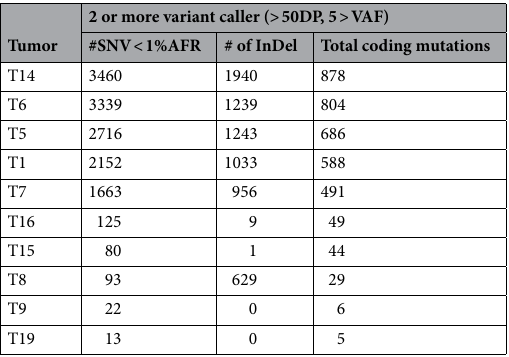
tumor samples with SBS26 signature (Table 2). The presence of SBS26 was highly correlated with the MSI scores (r 2 = 0.9908) (Fig. 2c). In LMR samples, we found other mutational signatures such as SBS18, possibly due to DNA damage by reactive oxygen species in two tumor samples (T9 and T15), SBS4, due to tobacco smoke carcinogens in three tumor samples, and SBS8, possibly due to defective homologous recombination repair in a tumor sample from a female ESCC patient (Fig. 2b). SCNAs in AA ESCC genomic regions encode cancer‑related genes. Our prior CGH analysis on 17 AA ESCC tumors revealed a preponderance of gains and losses in multiple chromosomal regions suggesting the involvement of a plethora of SCNAs 17 . In the present study, we evaluated SCNAs in an orthogonal panel of tumor samples from mostly late-stage AA patients with ESCC. Multiple regions of copy number gain and loss were observed in seven samples: T1, T5, T6, T9, T14, T16, and T19 (Fig. 3a and Supplementary Fig. S2). These SCNA- rich samples displayed on an average of 62 (ranging from 46 to 90) different chromosomal regions. Tumor sam- ples (T1, T7, T8, and T15) with fewer copy number aberrations showed on average 15 SCNAs (ranging from 5 to 25), presenting fewer copy number aberrations. Sample T5 and T9 had a moderate number of SCNAs (Fig. 3a). The most recurrent copy number changes along the AA ESCC genome were seen in the amplification of